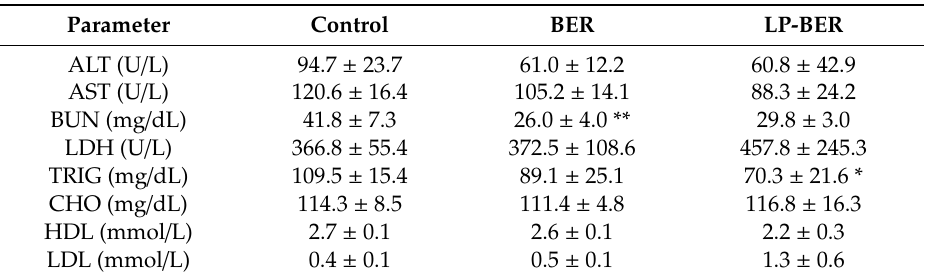
Table 7. Biochemical analysis after BER and LP-BER administration. In vivo toxicity of BER and LP-BER compared to untreated control mice after 10-days i.p.